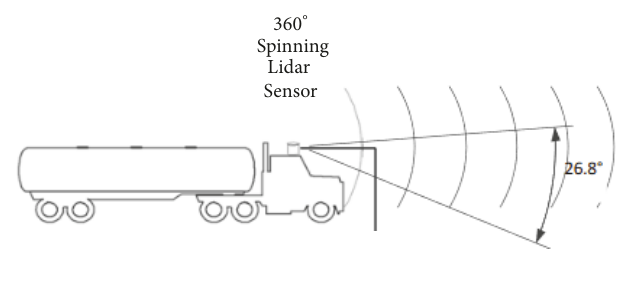
Figure 3: Vertical field of view of LiDAR sensor